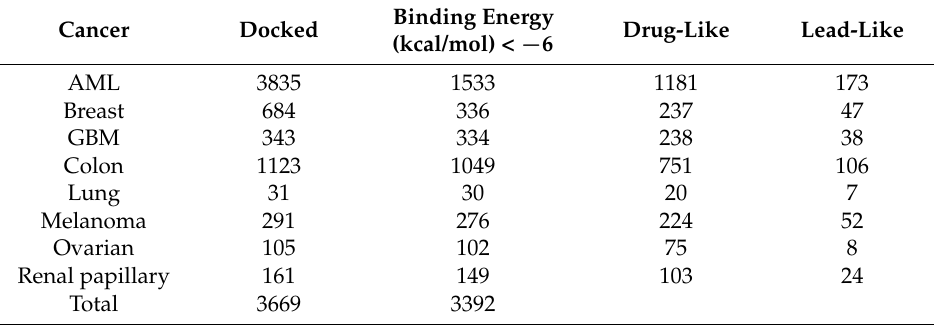
Table 2. Number of docked ligands, and drug-like or lead-like ligands